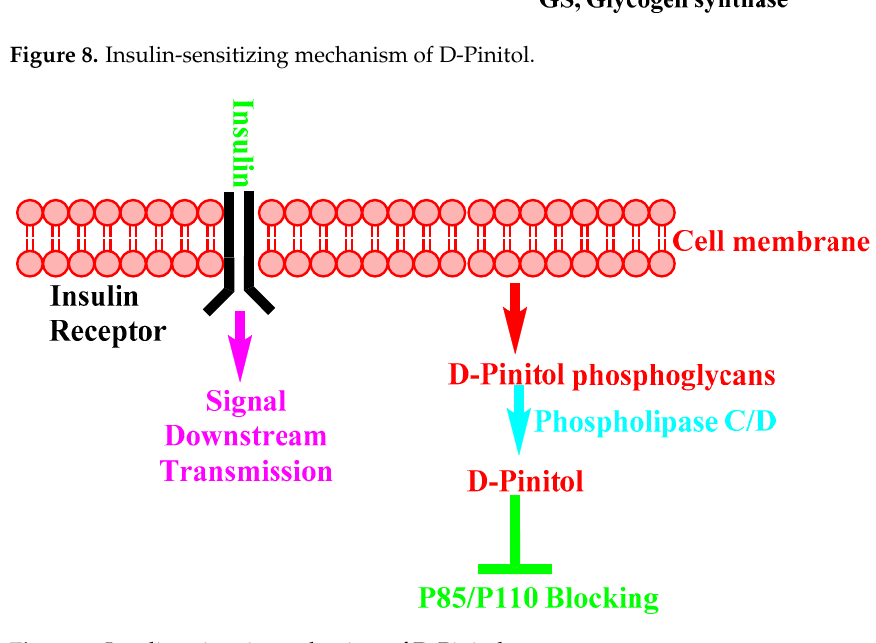
Figure 9. Insulin-mimetic mechanism of D-Pinitol.